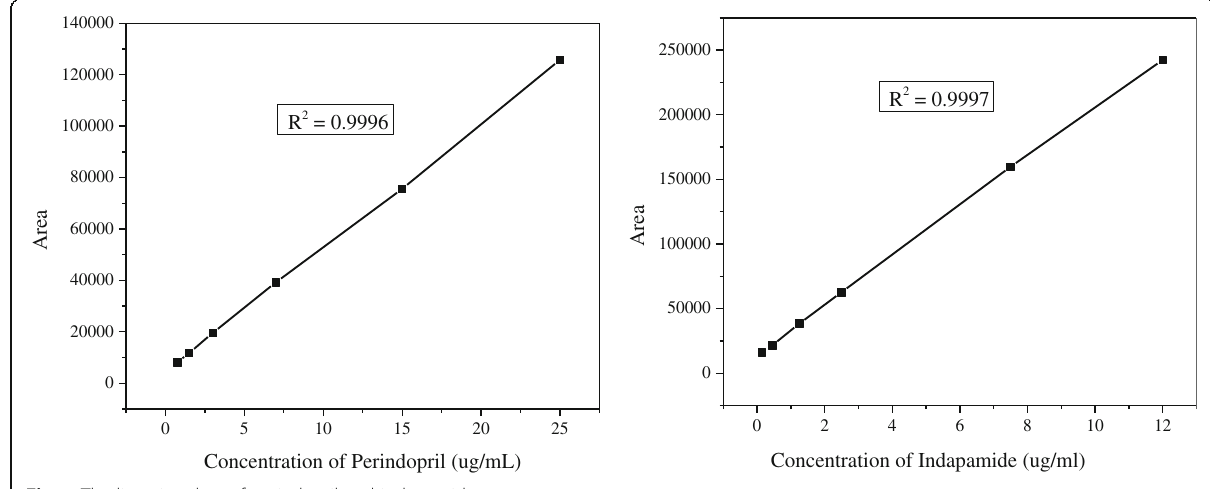
Fig. 4 The linearity plots of perindopril and indapamide